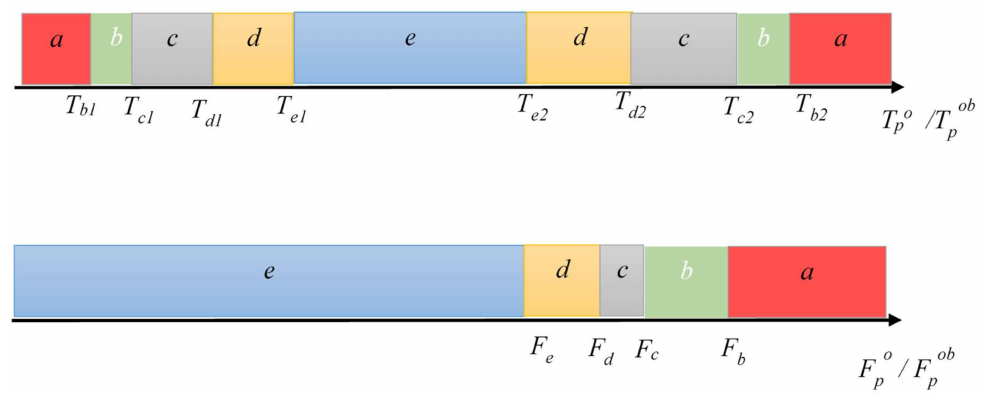
Figure 4. Conditions for implementing appropriate maintenance or repair recommendations (source: own